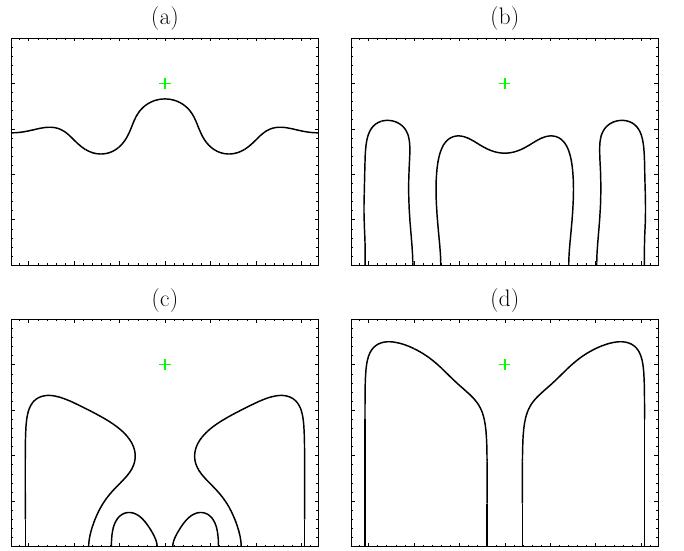
Figure 9. Moving contact line at T = 10 ( a ), T = 20 ( b ), T = 30 ( c ), and T = 150 ( d ). L X = 27, θ s = 60 ◦ (75 ◦ inside contamination spot, denoted by a green